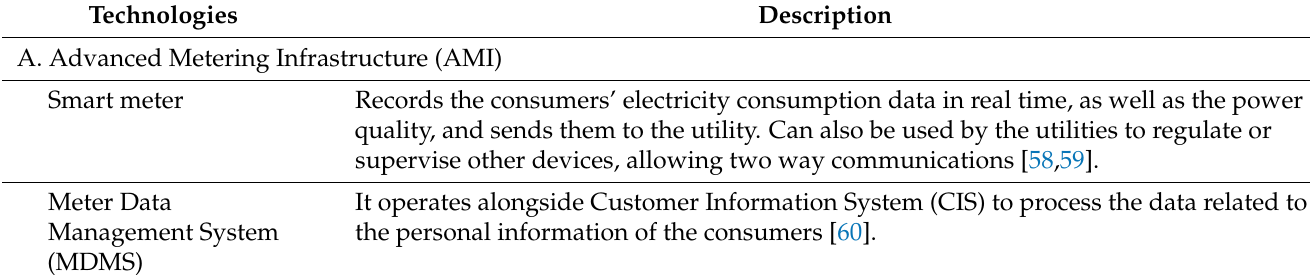
Table 5. Summary of technologies and features used in the smart grids and smart power management schemes.